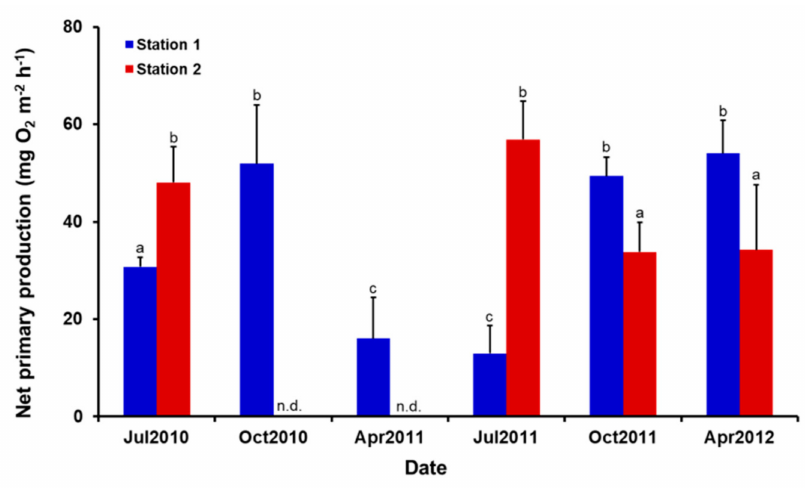
Figure 3. Ex situ net primary production rates (given as mg O 2 m − 2 h − 1 ) over the course of the seasons at both stations S1 and S2. The data are given as mean values with standard deviations ( n = 3). Different letters reflect significantly different mean values (Tukey’s test, p < 0.05). n.d.: not detected.